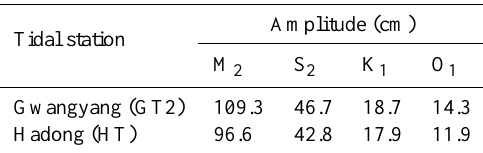
Fig. 1. Map of the study area. The solid circles indicate the CTD stations. The star mark denotes the locations of the Gwangyang (GT1 and GT2) and Hadong (HT) tidal stations. Table 1. Observed tidal amplitudes for M 2 , S 2 , K 1 and O 1 at the Gwangyang and Hadong tidal